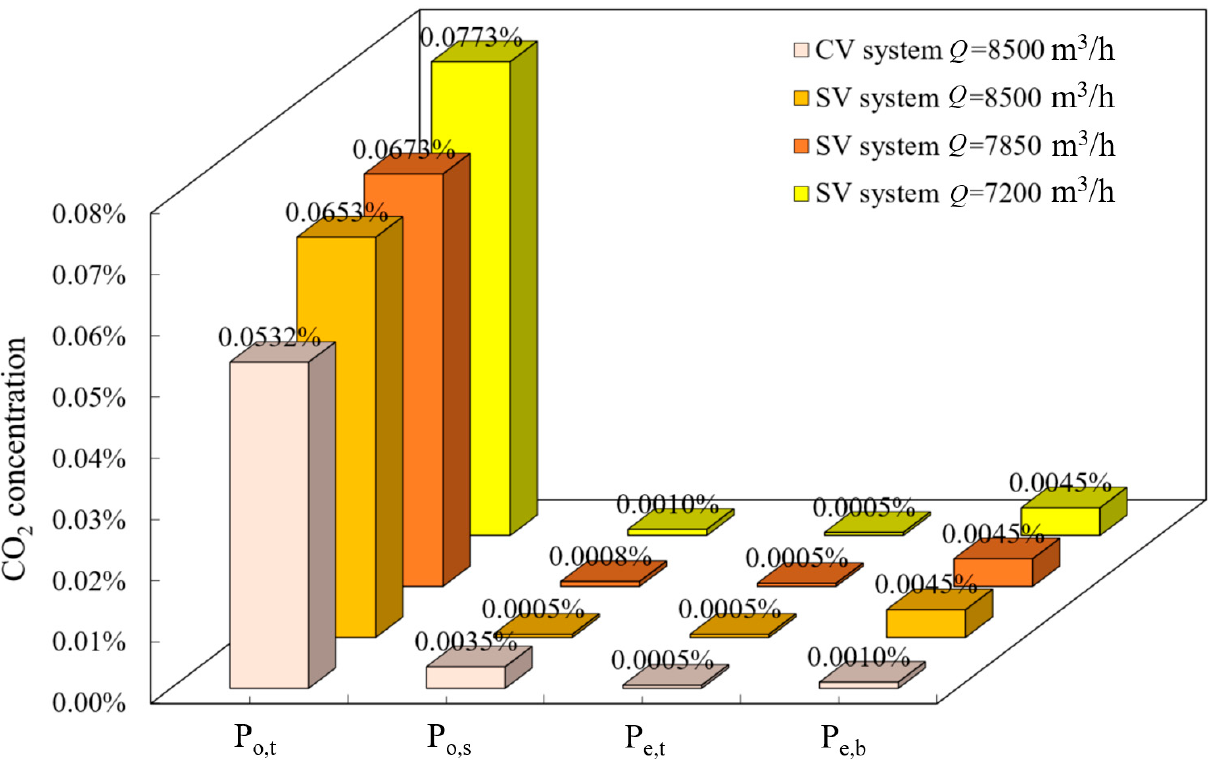
Figure 6. Concentrations of CO 2 at various monitored points.